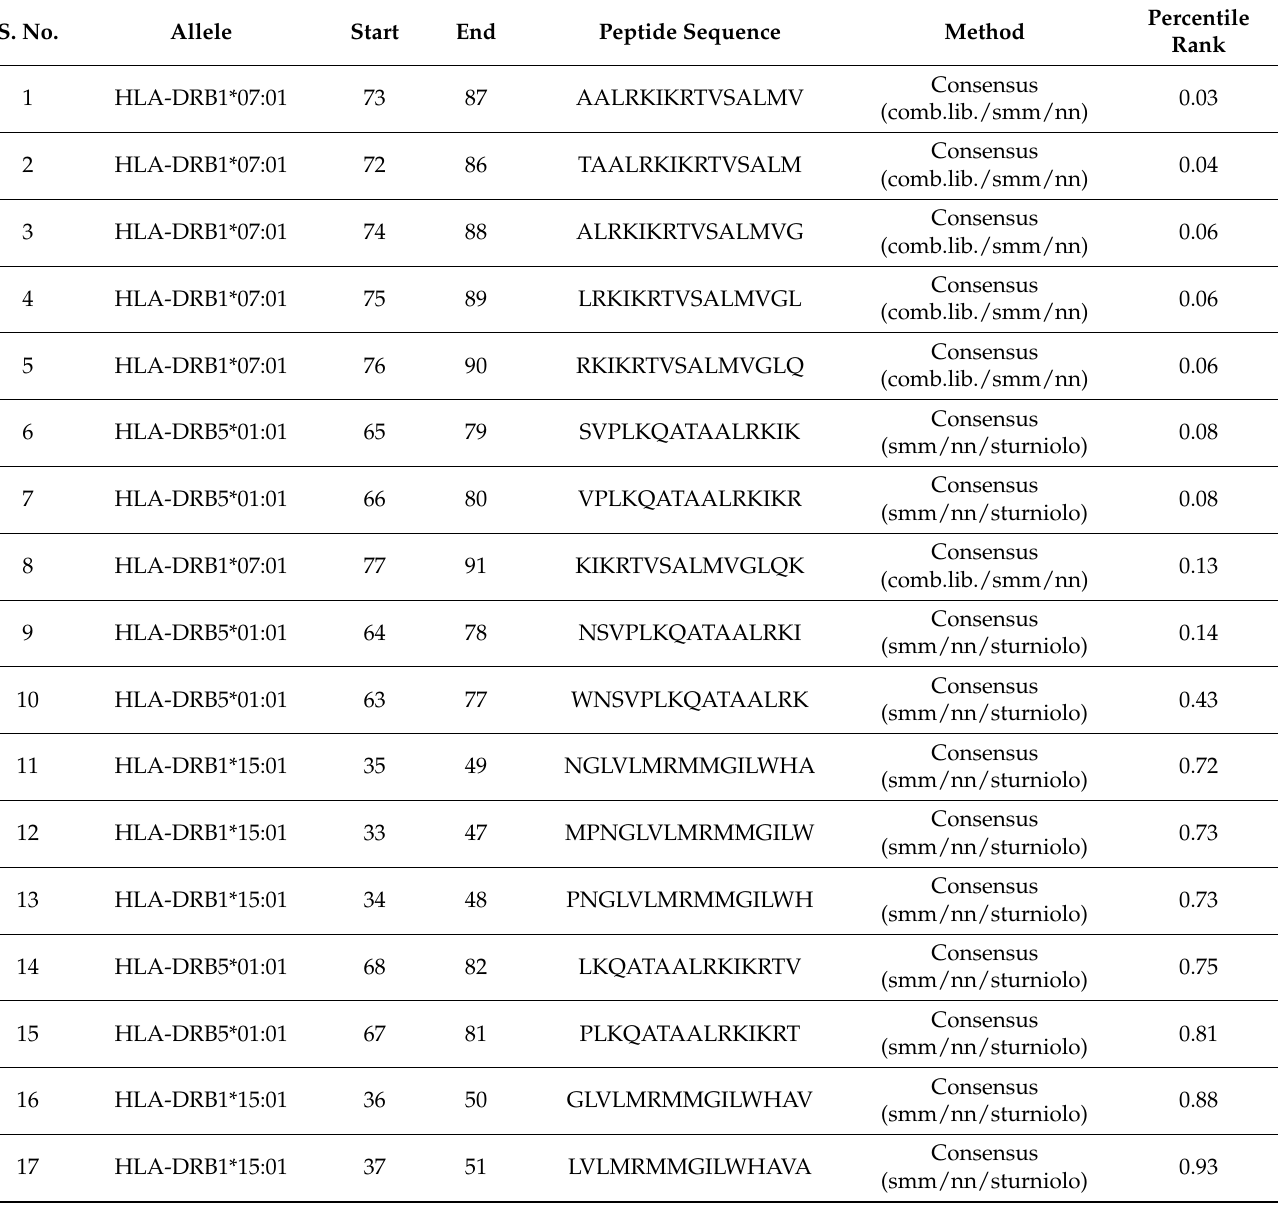
Table 2. Predicted HTL epitopes. The table shows the specific allele against which the HTL epitopes are predicted. Furthermore, it also shows the methods and percentile rank of each peptide. The HTL epitopes shown in bold are the finally selected epitopes for multi-epitopes vaccine